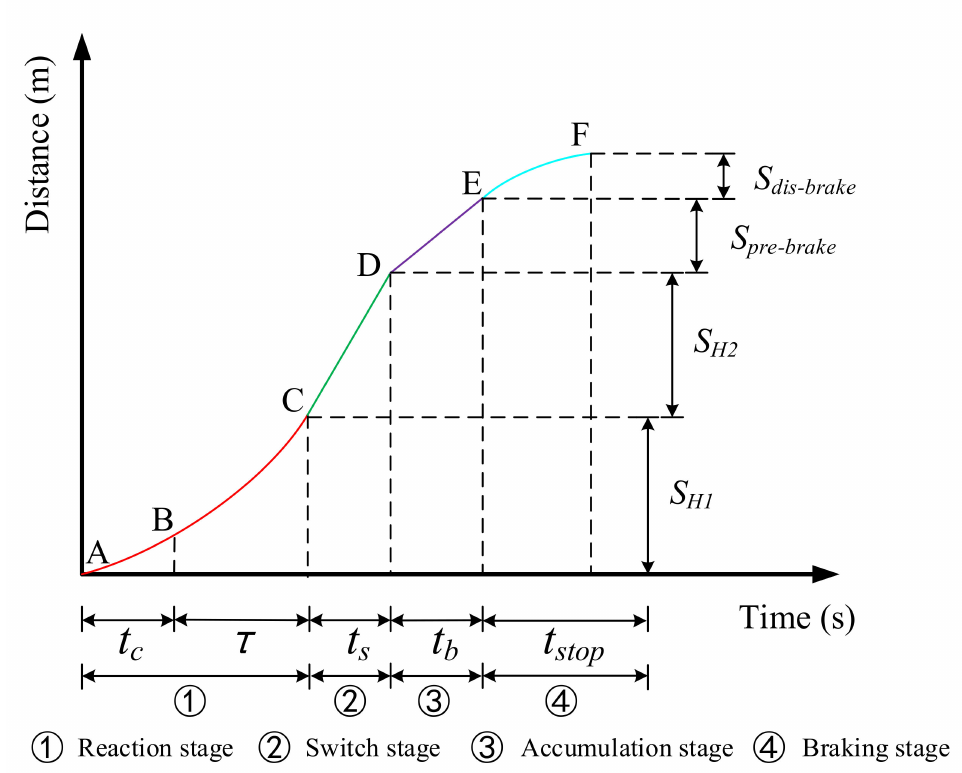
Figure 3. Analysis of vehicle movement